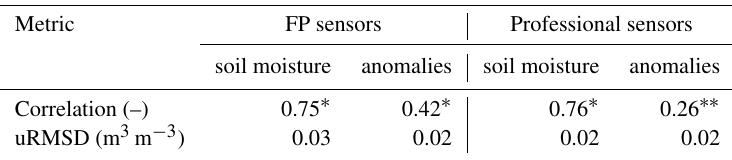
Table 4. Evaluation results of the ASCAT soil moisture product at the HOAL catchment with respect to the FP sensor and professional sensor data. Results are given for the soil moisture observations and the soil moisture